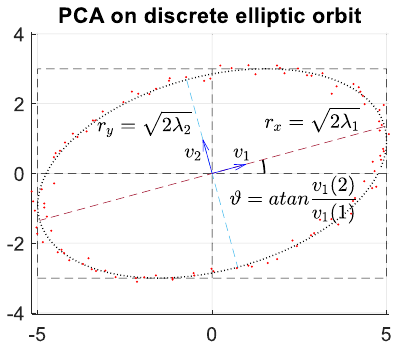
Fig. 8. PCA on noisy elliptic orbit (synthetic, noise std =0.15).